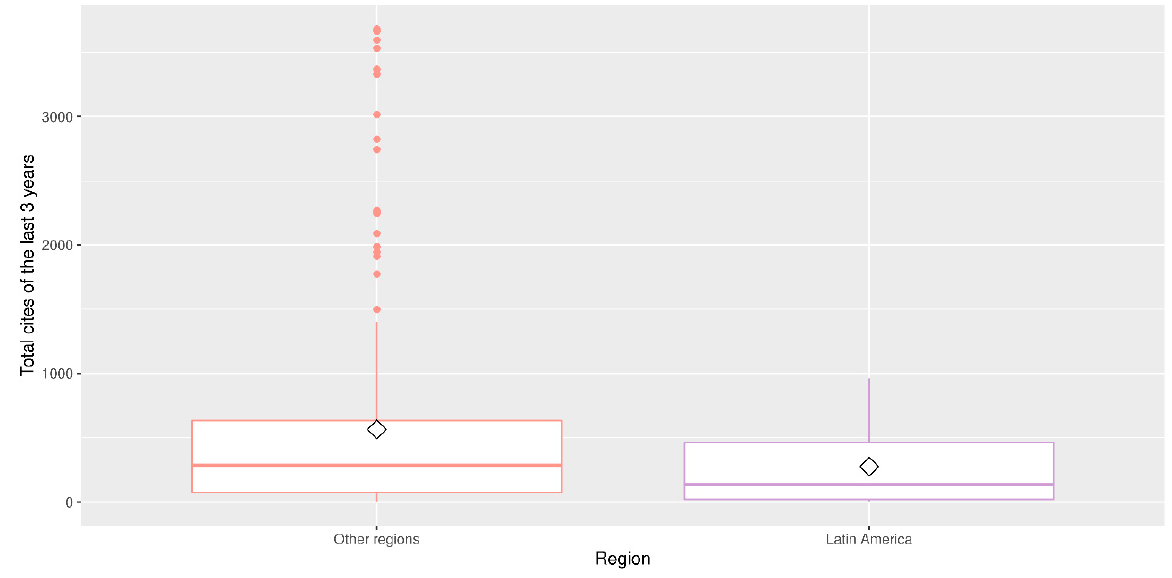
Figure 11. Comparison of total citations between LAC and other regions.